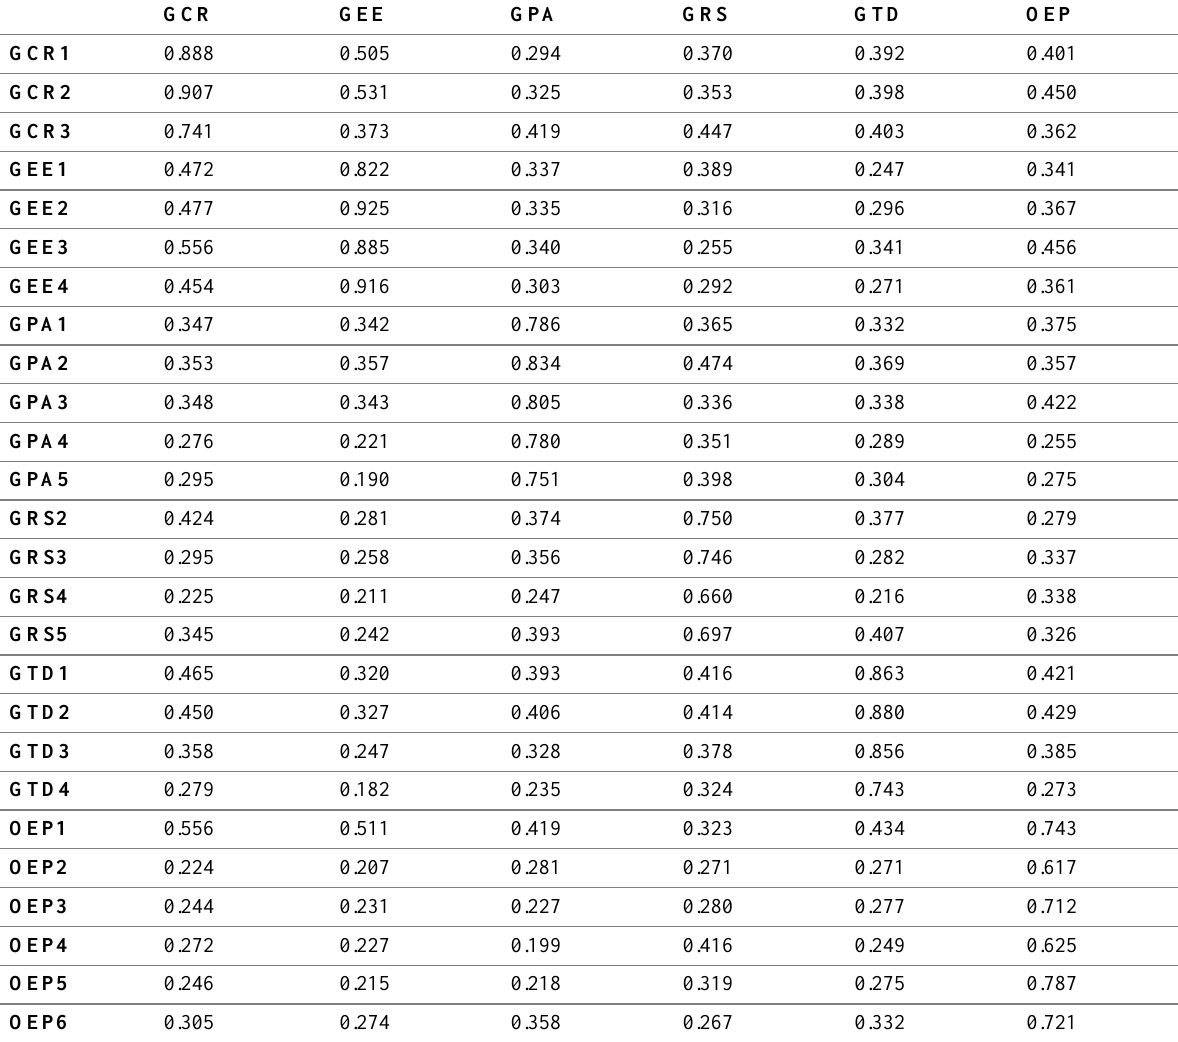
Table 2: PLS output of cross loadings